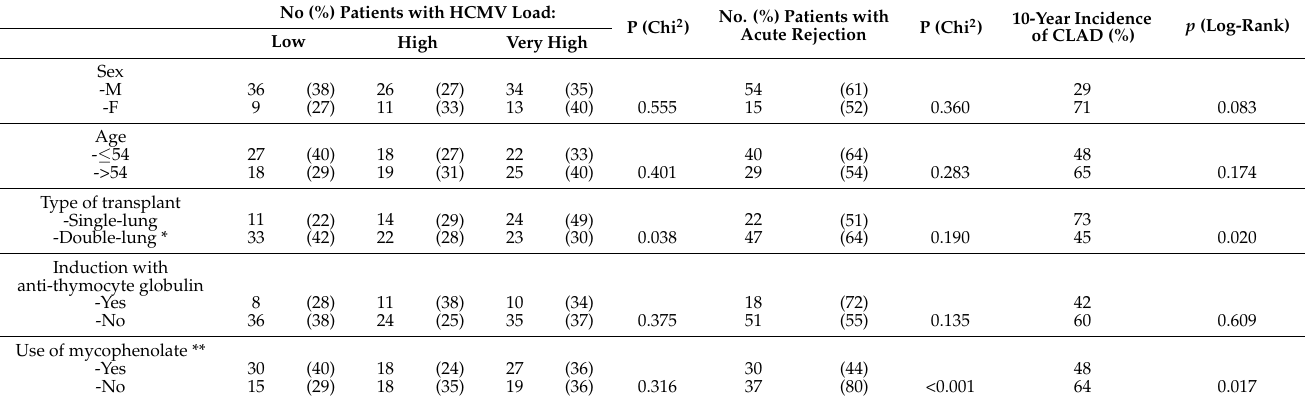
Table 2. Factors associated with CMV load, acute rejection or chronic lung allograft dysfunction (CLAD). No (%) Patients with HCMV Load: No. (%) Patients with P (Chi 2 ) Acute Rejection P (Chi 2